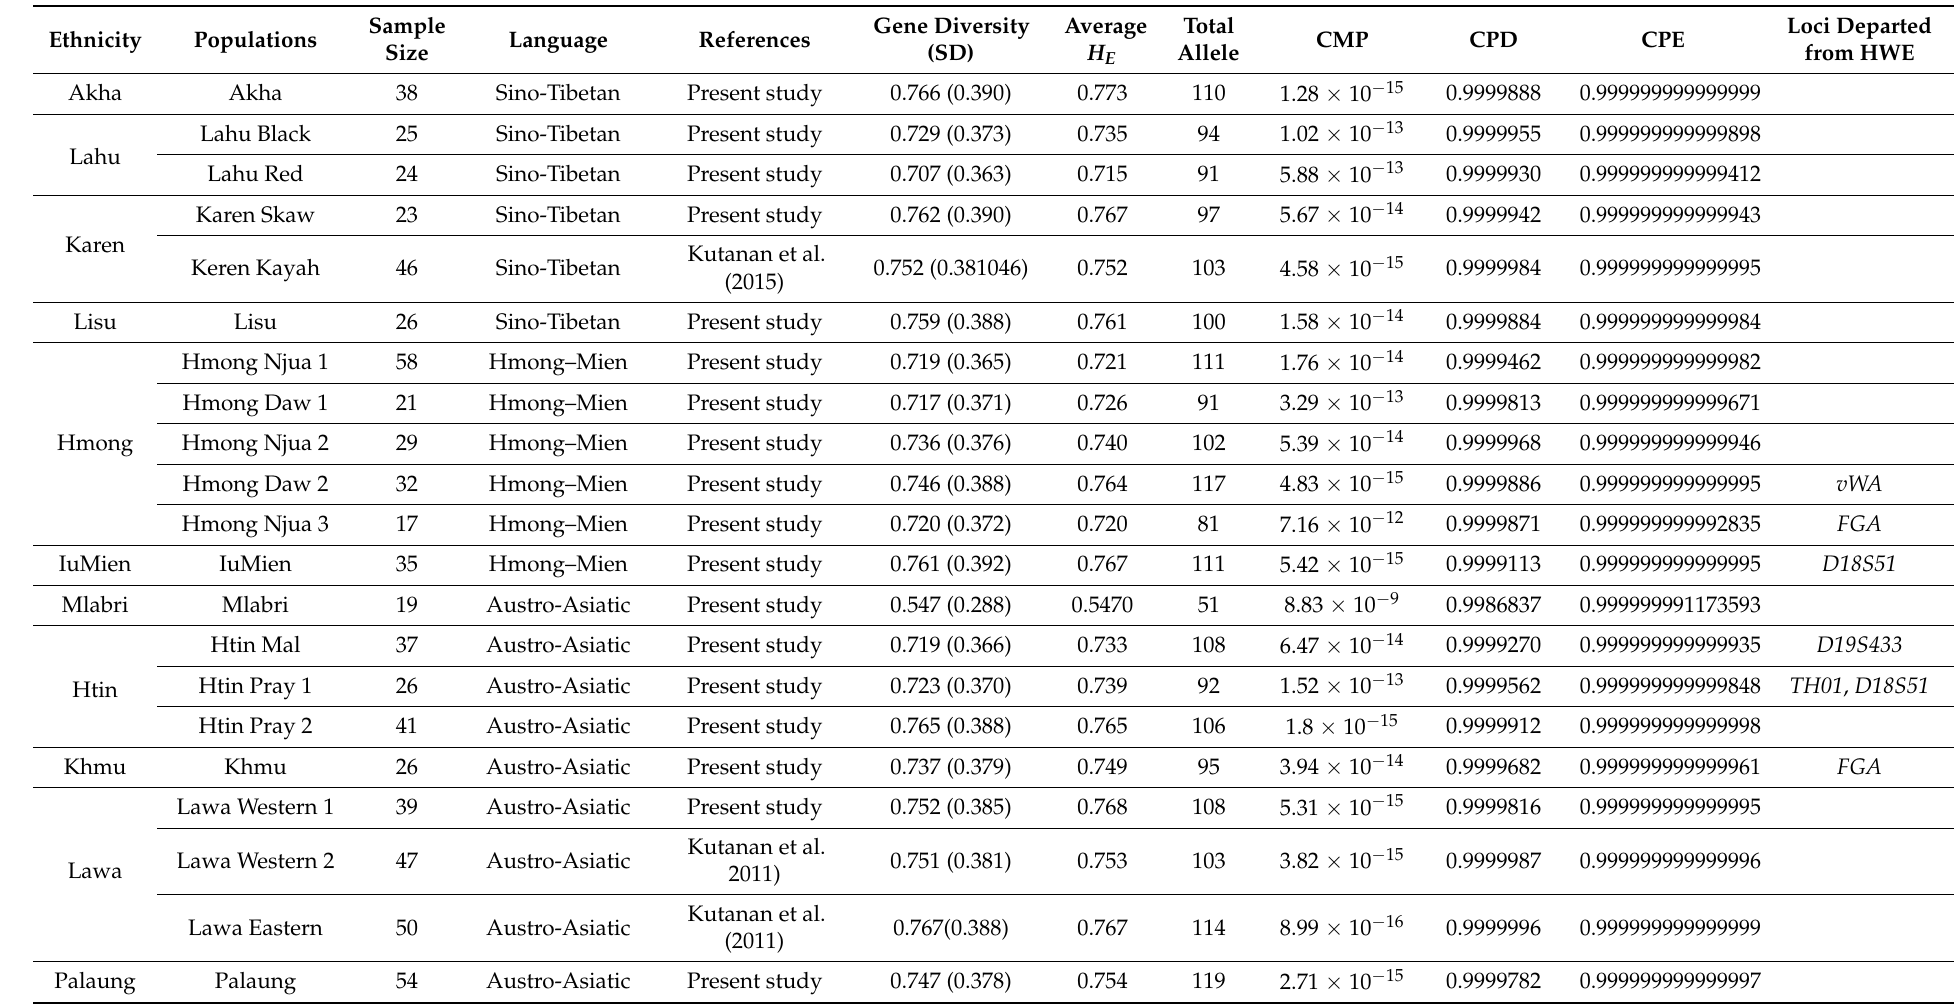
Table 1. General information of studied populations, genetic diversity indices and forensic